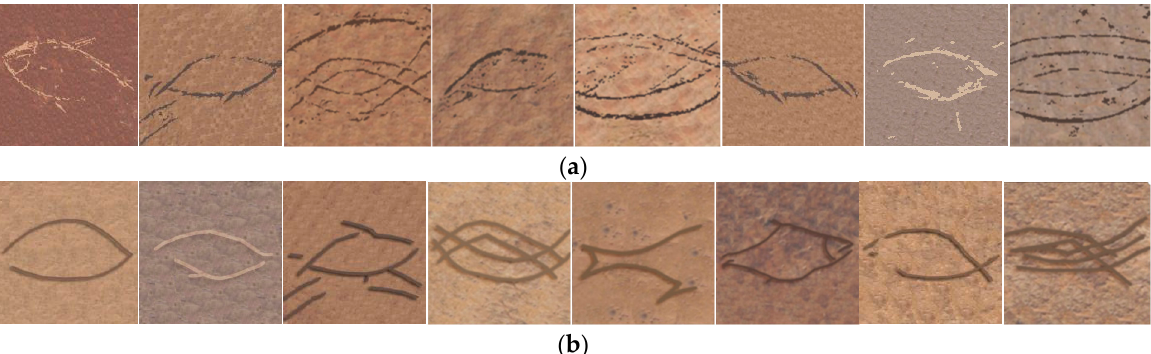
Figure 8. Fish-shape images generated by various network models. ( a ) Fish shape images generated by the multi‑attention network. ( b ) Fish shape images generated by the channel attention network.